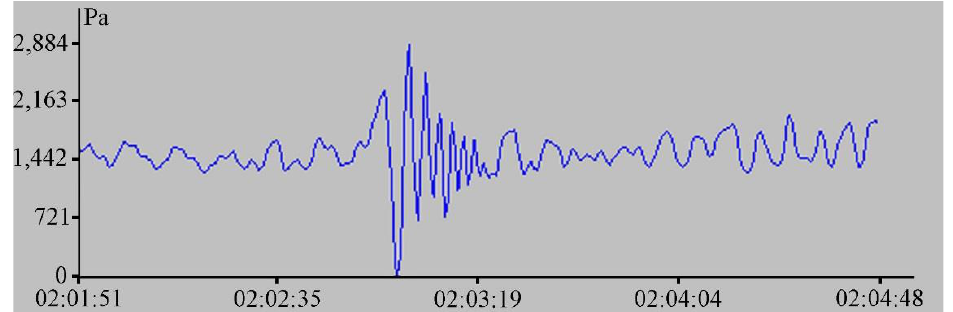
Figure 7. A recording section of the supersensitive detector of hydrosphere pressure variations for 28 September 2020, installed on the seabed at a depth of 4 m in Alekseev Bay, Popov Island.